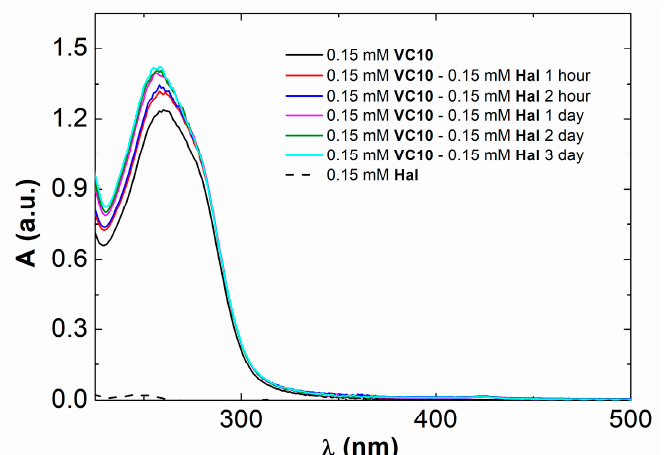
Figure 2. UV-Vis absorption spectra of 0.15 mM VC10 , 0.15 mM VC10 –0.15 mM Hal in H 2 O, and 0.15 mM Hal in EtOH.